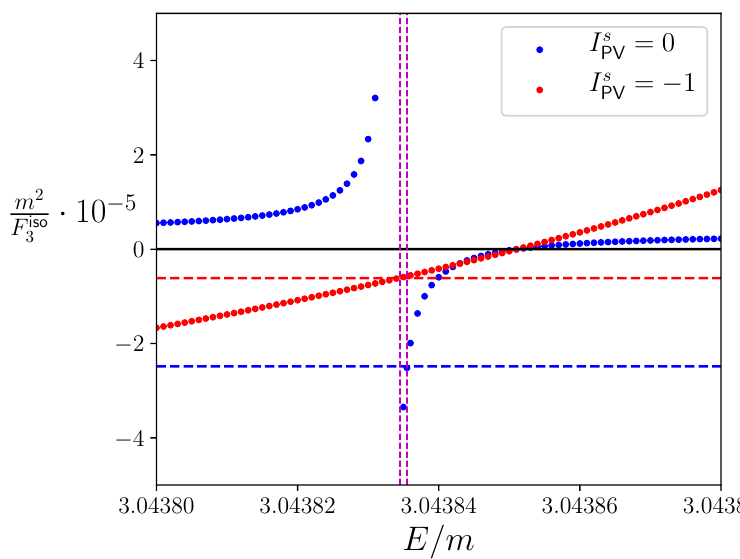
Figure 15 . As for (cid:12)gure 13 but for the (cid:12)rst excited state. The dashed magenta lines correspond to the values of E 1 ( I PV = 0; mL = 30) and E 1 ( I PV = (cid:0) 1; mL = 30) obtained from the constant approximations m 2 K iso ( I PV = 0) = 2 : 4828 (cid:1) 10 5 and m 2 K iso ( I PV = (cid:0) 1) = 6 : 1365 (cid:1) 10 4 . The df ; 3 df ; 3 discrepancy between the two magenta lines is due to our neglect of the higher-order terms in the threshold expansion of K df ; 3 .